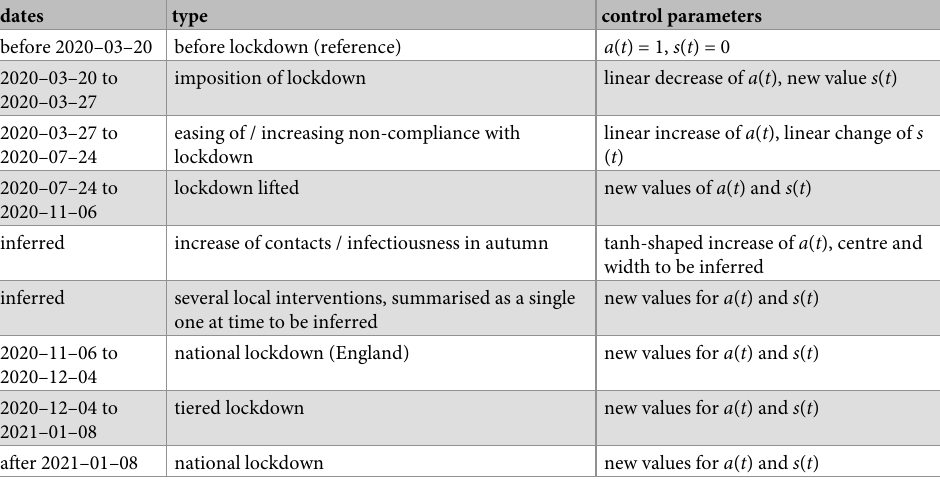
a ( t ) = 1, s ( t ) = 0 linear decrease of a ( t ), new value s ( t ) linear increase of a ( t ), linear change of s ( t ) width to be inferred new values for a ( t ) and s ( t )